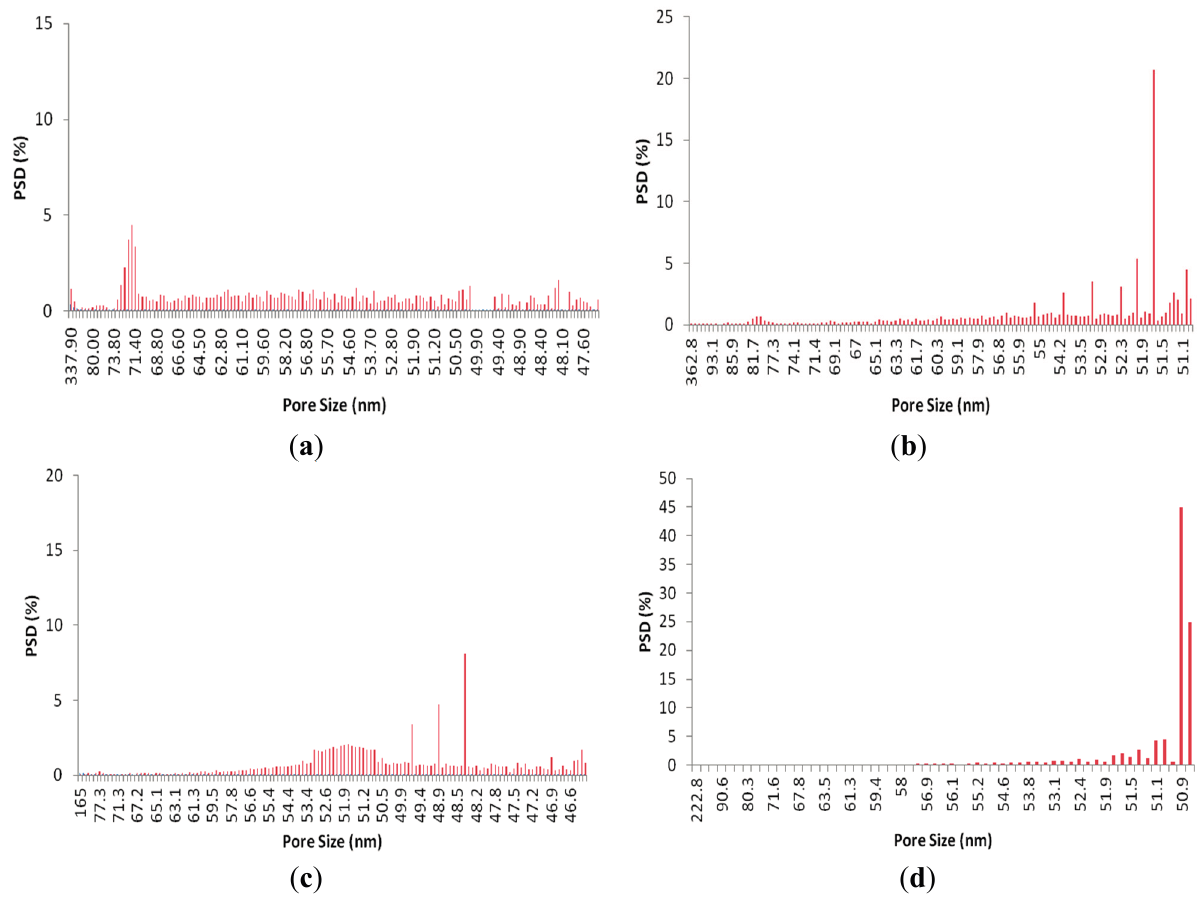
Figure 5. Pore Size Distribution of ( a ) A-1; ( b ) A-2; ( c ) B-1 and ( d ) B-2